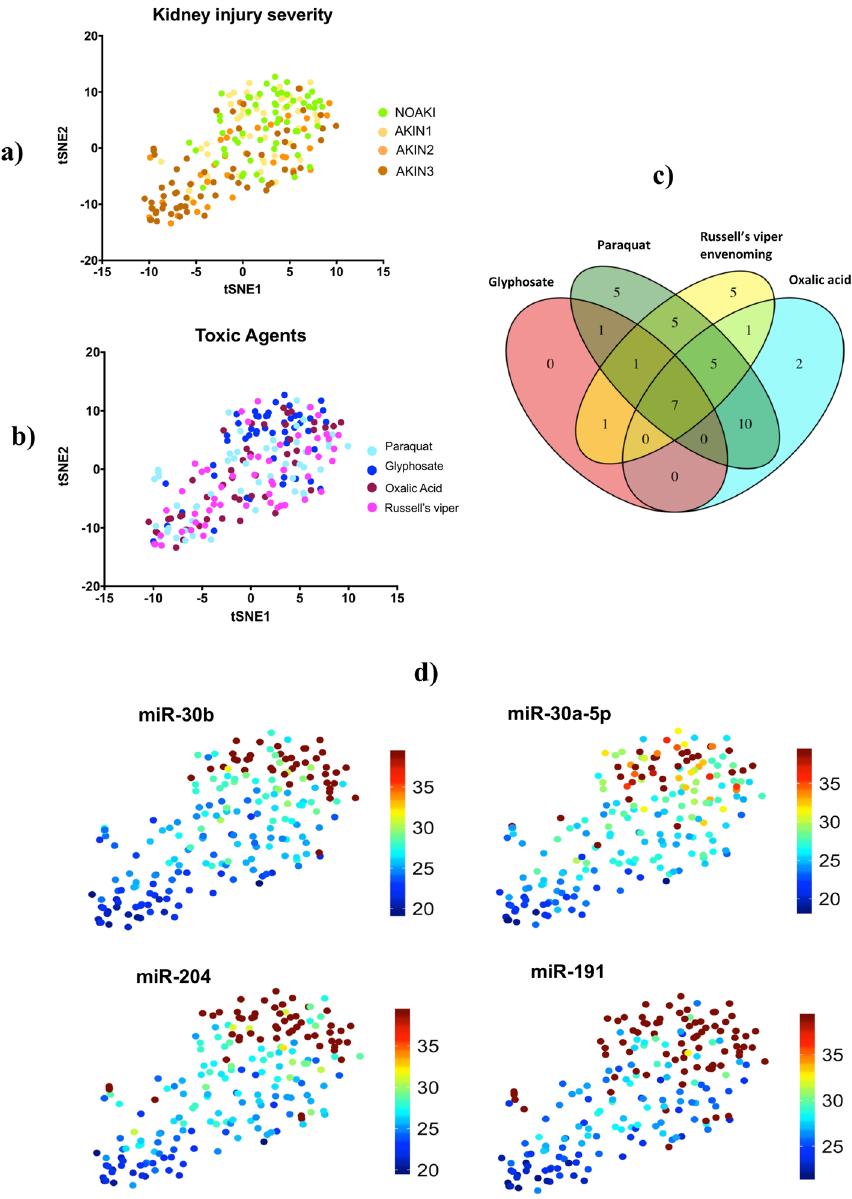
Figure 3. Plot of the non-linear tSNE map of samples from 4-dimensional principal component space into two dimensions showing tSNE analysis applied using all (n=43) differentially expressed microRNAs (Supplementary Table 3). ( a ) tSNE plots show the clusters of all different microRNAs in different AKI stages: NOAKI, AKIN1, AKIN2 and AKIN3 caused by all poisons. ( b ) tSNE plots show the clusters for different poisons: oxalic acid, glyphosate, paraquat and Russell’s viper envenoming in validation cohort. ( c ) Venn Diagram demonstrating overlap of 43 altered microRNAs in AKI (> 2.8 fold change, p < 0.05) amongst the nephrotoxic agents. microRNAs altered in different agents: Oxalic acid = 25, glyphosate = 10, paraquat = 34 and Russell’s viper = 25. ( d ) tSNE plots show best four microRNAs clusters in AKIN2/3 patients in all four nephrotoxic agents. Blue to red presented in the color bar indicates high to low microRNA expression (data shown in normalized Ct values, therefore a lower value represents a higher expression)